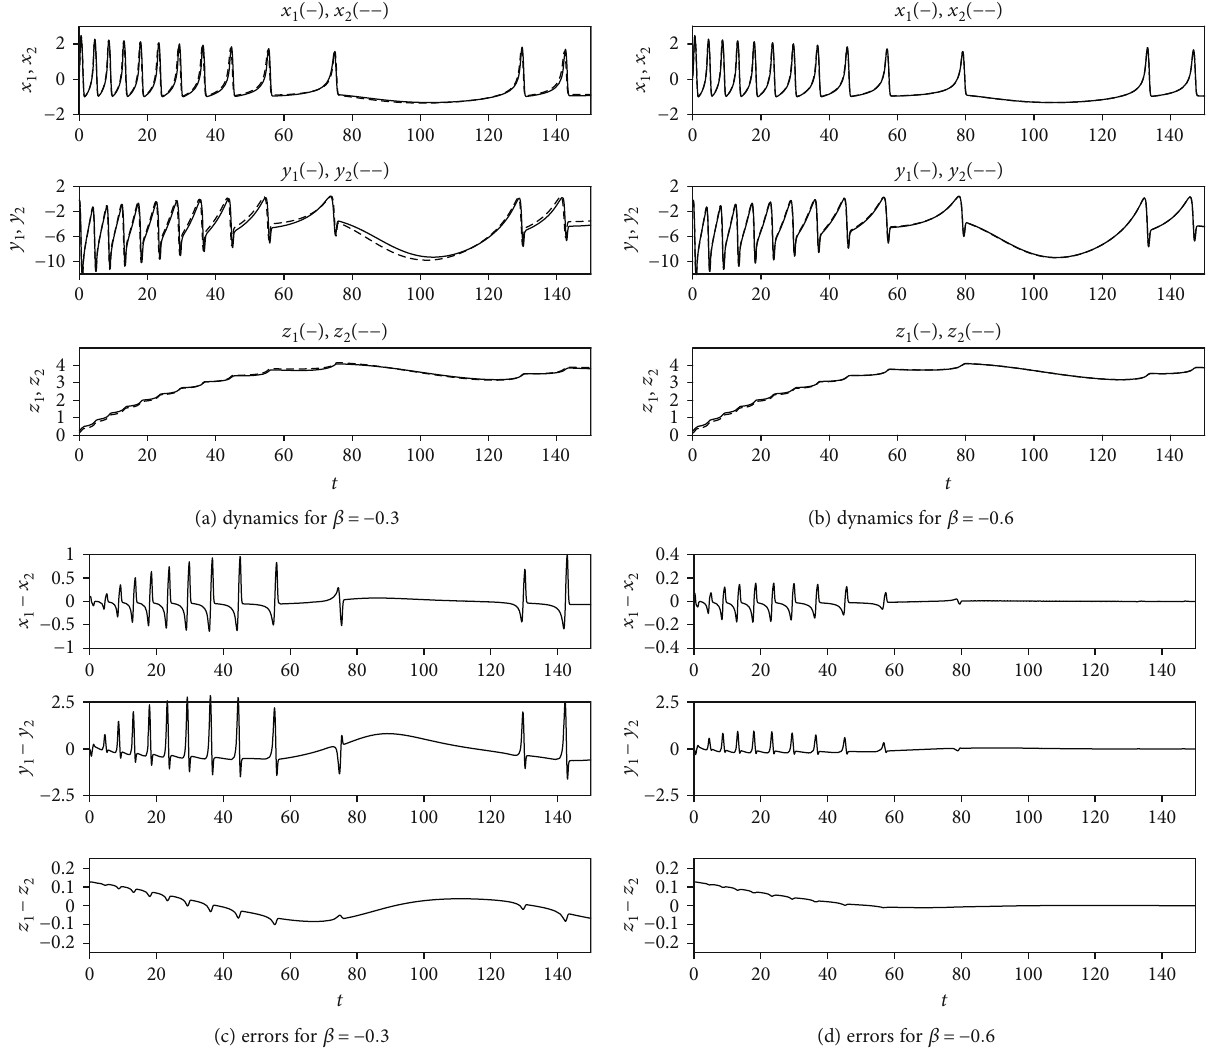
Figure 2: The dynamics of system (2) with r = 0 : 013 and I = 3 : 0 : (a) β = − 0 : 3 and (b) β = − 0 : 6 . Synchronization errors: (c) β = − 0 : 3 and (d) β = − 0 : 6 . The initial conditions are x